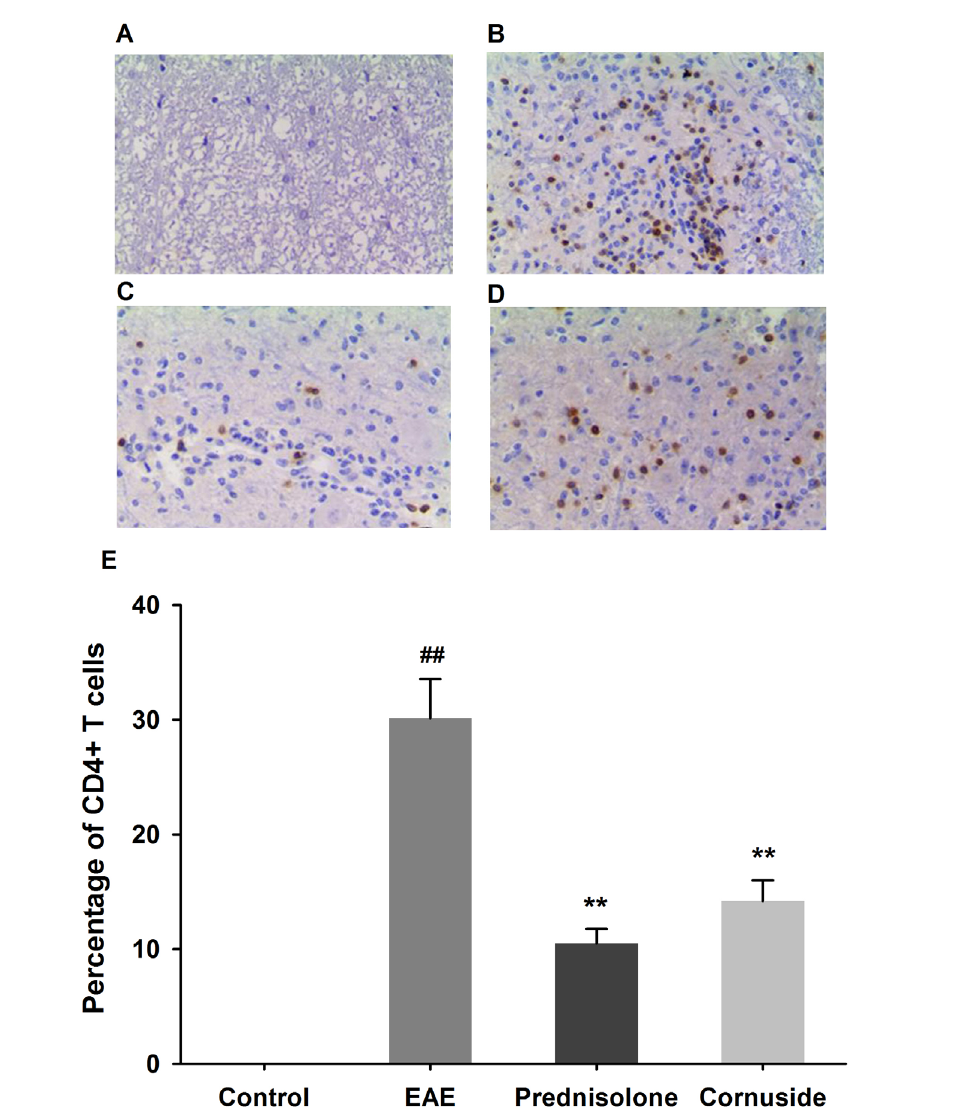
FIGURE 2 - Immunohistochemical (IHC) staining for CD4 positive T lymphocytes in the spinal cord. The representative CD4 positive T lymphocytes of the (A) Control, (B) EAE, (C) Prednisolone, and (D) Cornuside groups. (E) Percentage of CD4 + T lymphocytes. ** P <0.01 for the cornuside or prednisolone group versus the EAE group, ## P <0.01 for the EAE group versus the control group. Original magnification